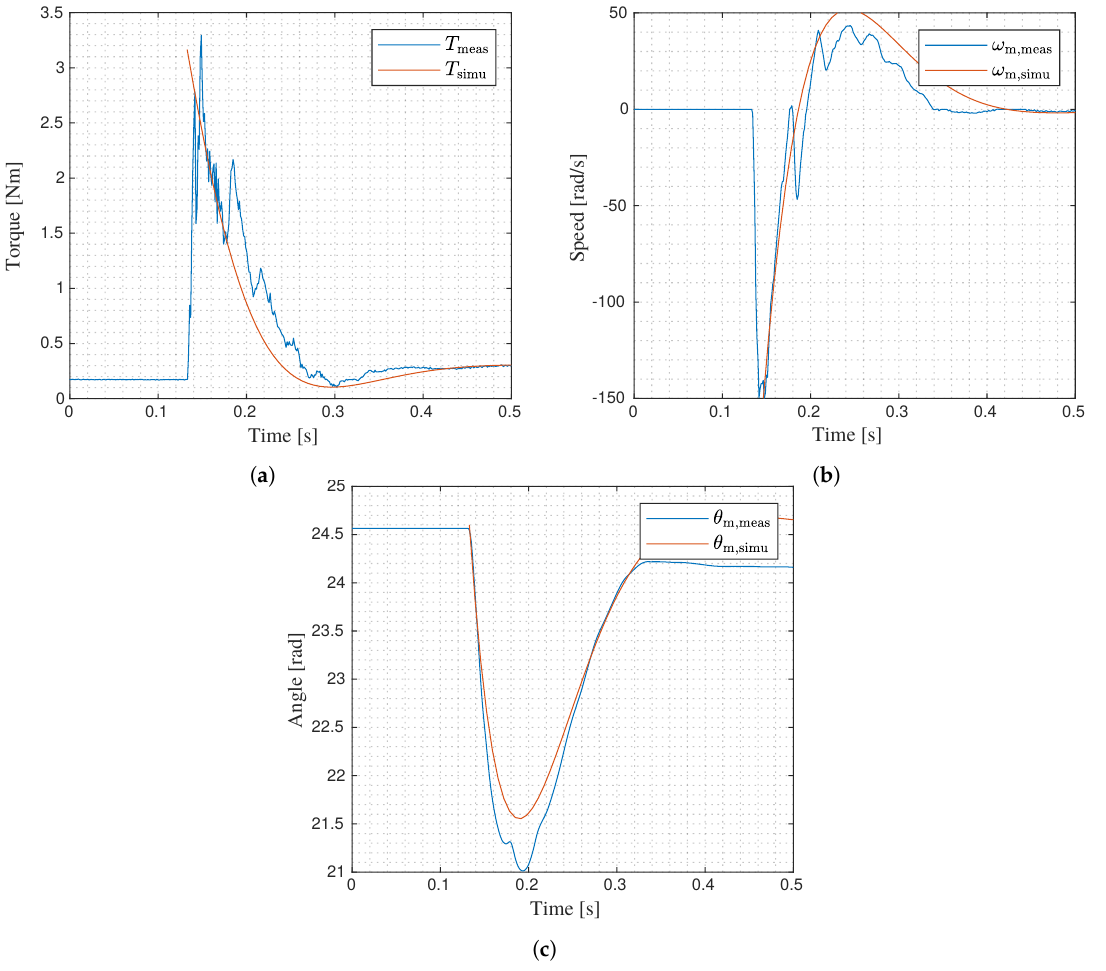
Figure 15. Measured ( T meas , ω m,meas and θ m,meas ) and simulated ( T simu , ω m,simu and θ m,simu ) results from the experiment (listed in Table A3) conducted on the active impedance controller ( a ) T meas , ( b ) ω m,meas , ( c ) θ m,meas . The load configuration, proposed in Appendix K, is used with 3kg mass released from a distance of 10cm. The simulated results are offset and scaled to match the amplitude and start angle of the measurements. The torque T meas is estimated from the quadrature current by T meas = K t i q